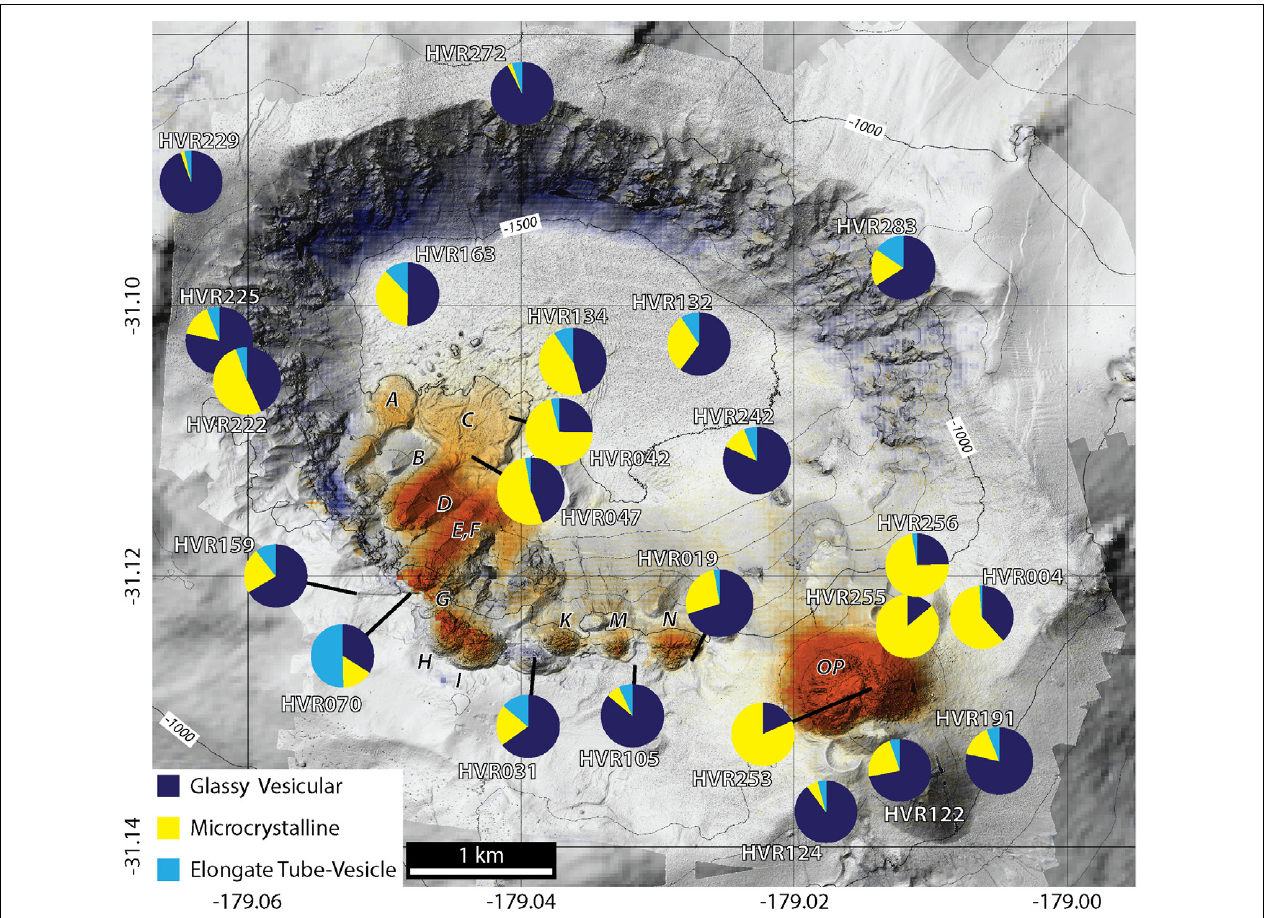
FIGURE 5 | Spatial distribution of componentry data plotted by sample location. Note concentrations in elongate tube-vesicle particles (light blue) around Lava G. Microcrystalline particles (yellow) concentrations are present around Dome OP and the lava flows A–E on the southwest caldera wall, and caldera floor. Glassy vesicular particles (dark blue) are found in every sample and are the dominant component of the overall deposit. Several samples are offset from their sampling location, denoted with a black-tie